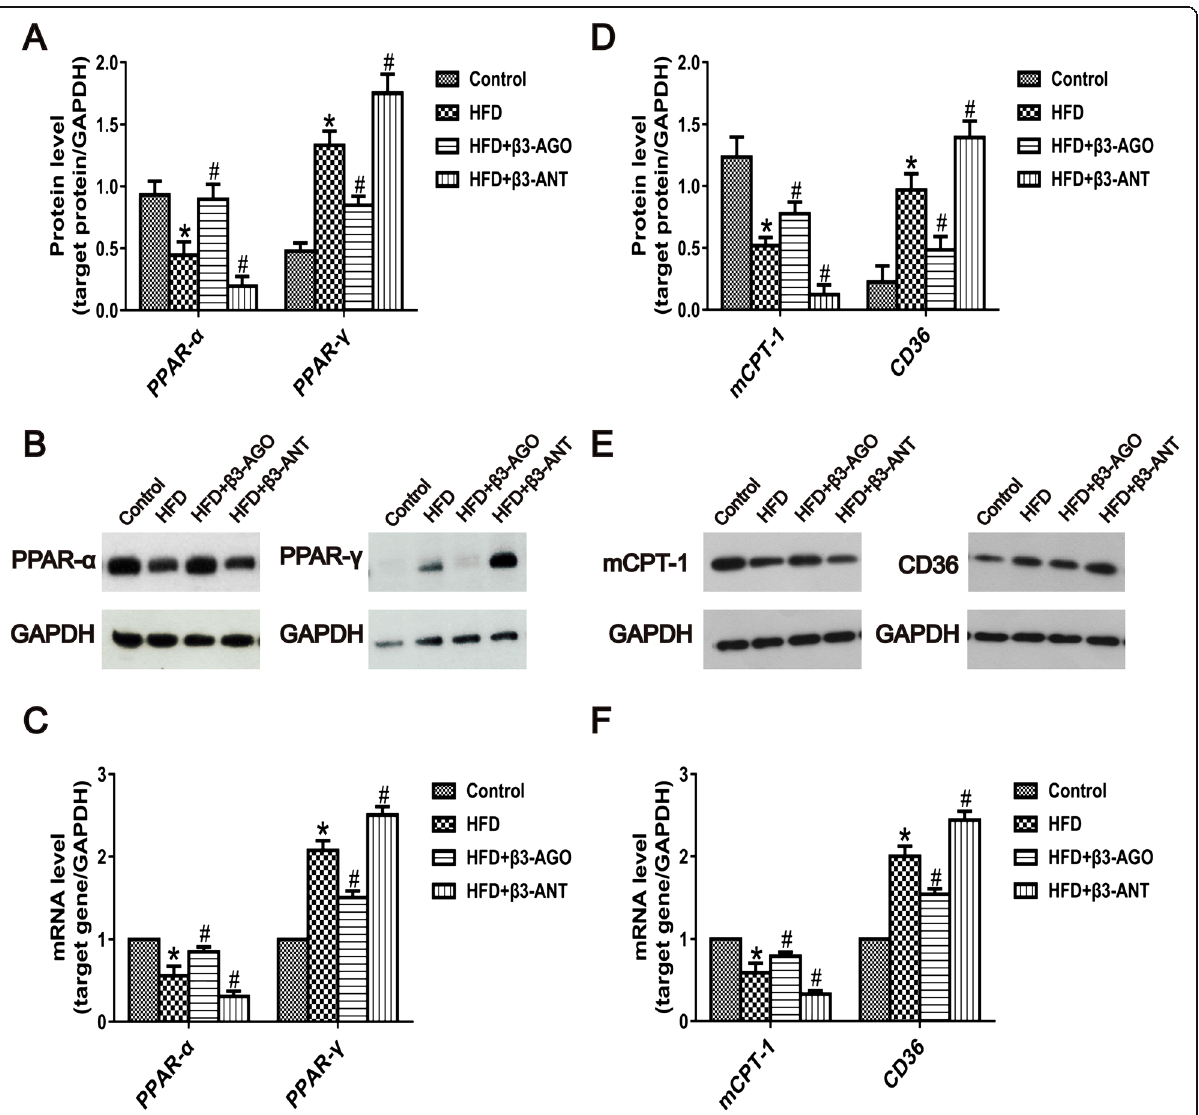
Fig. 4 The β 3-AR agonist BRL37344 modulated key proteins and genes for FFA β -oxidation. a Quantitative analysis of the protein levels of PPAR- α and PPAR- γ in the livers of rats in the control, HFD, HFD + β 3-AGO and HFD + β 3-ANT groups (each group, n = 8). b Representative western blot bands of the PPAR- α and PPAR- γ proteins in the livers of rats in the control, HFD, HFD + β 3-AGO and HFD + β 3-ANT groups. c Quantitative analysis of the expression of the PPAR- α and PPAR- γ genes in the control, HFD, HFD + β 3-AGO and HFD + β 3-ANT groups (each group, n = 8). d Quantitative analysis of the protein levels of mCPT-1 and CD36 in the livers of rats in the control, HFD, HFD + β 3-AGO and HFD + β 3-ANT groups (each group, n = 8). e Representative western blot bands of the mCPT-1 and CD36 proteins in the livers of rats in the control, HFD, HFD + β 3- AGO and HFD + β 3-ANT groups. f Quantitative analysis of the expression of the mCPT-1 and CD36 genes in the control, HFD, HFD + β 3-AGO and HFD + β 3-ANT groups (each group, n = 8). * P < 0.05 vs the control group, # P < 0.05 vs the HFD